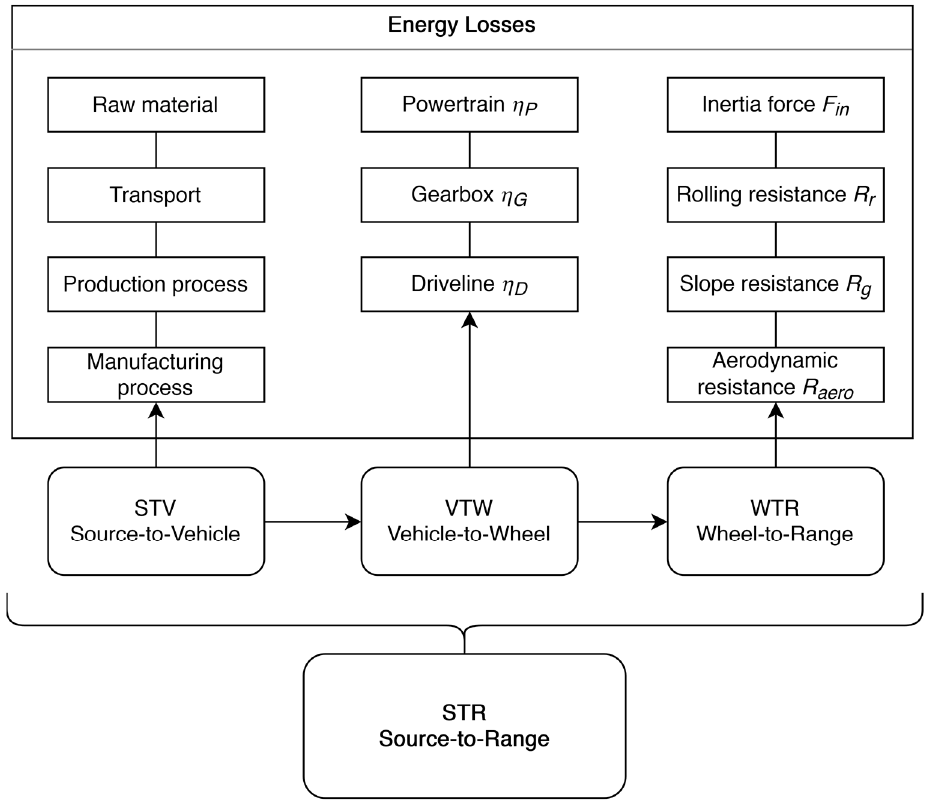
Figure 6. Source-to-range model and energy losses.